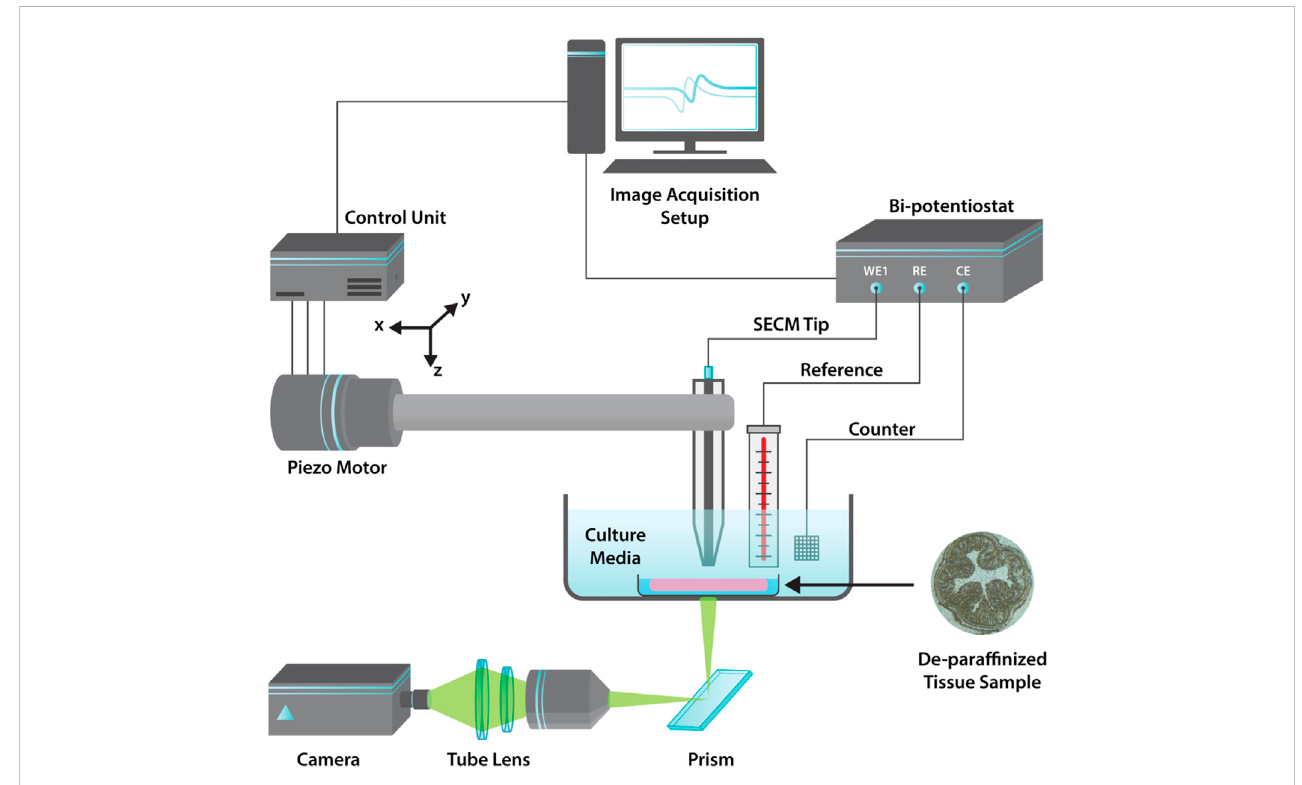
FIGURE 1 Graphical schematic illustration of the AC-SECM imaging apparatus with a three probe set-up used for dielectric mapping of colon